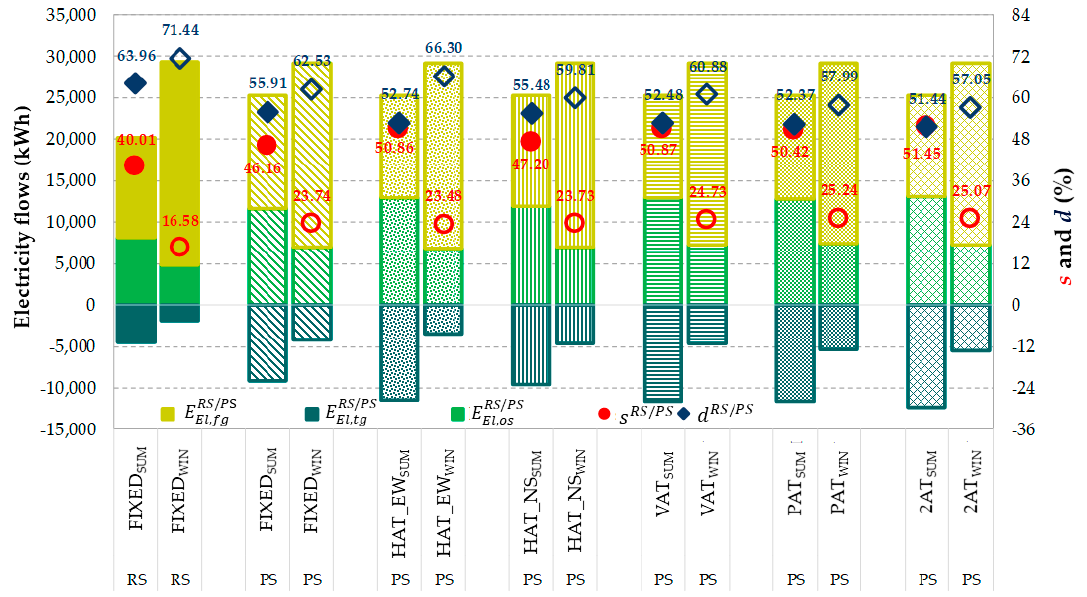
Figure 6. Electricity flows, s and d index for RS and PS in all solar tracker system configurations on seasonal basis.